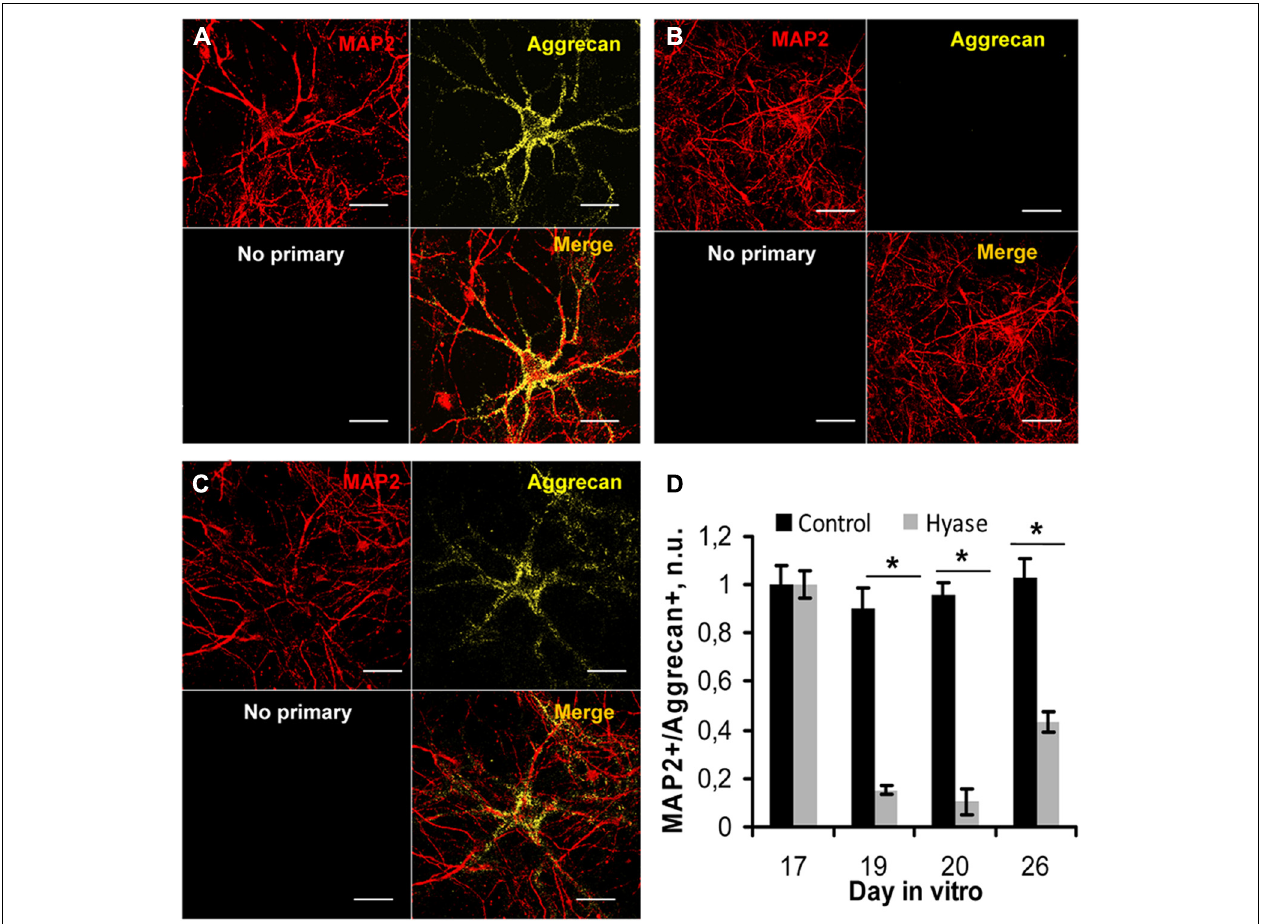
(A–C) . Scale bar: 20 μ m. (D) The fraction of MAP2-positive neurons bearing aggrecan-positive PNNs at different time intervals after Hyase treatment (ANOVA; * p < 0.05; N = 5 cultures/DIV).The data are from five independent culture preparations.The values shown were normalized by the mean fractions of PNNs in the control and Hyase groups on the 17th DIV. n.u., normalized units; MAP2, microtubule-associated protein 2; Hyase,